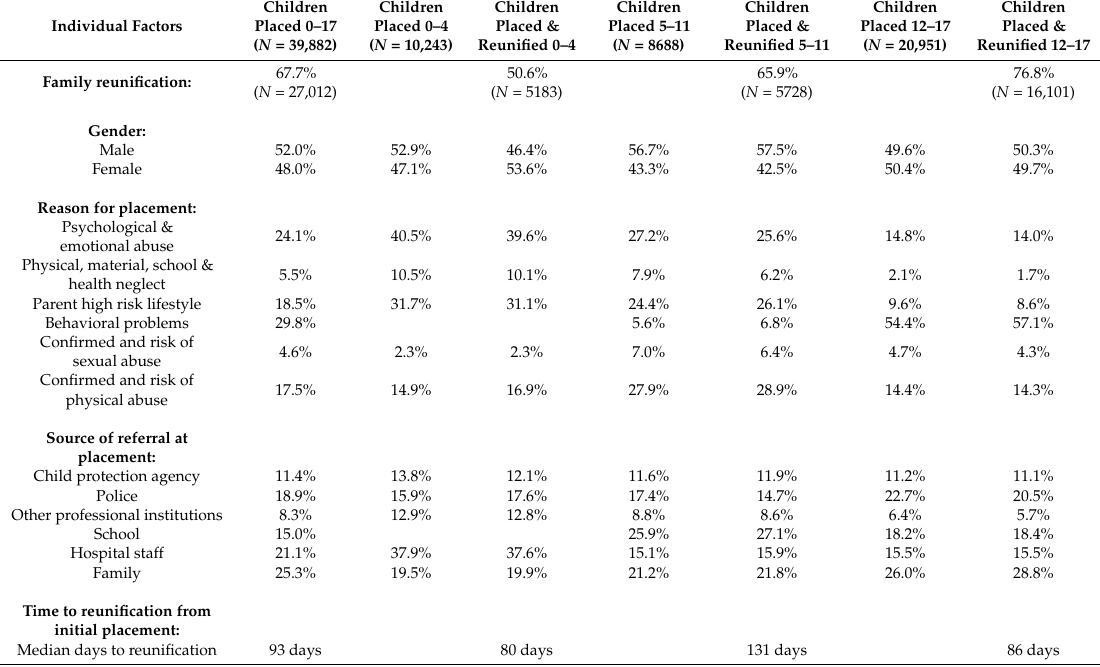
Table 1. First-level descriptive